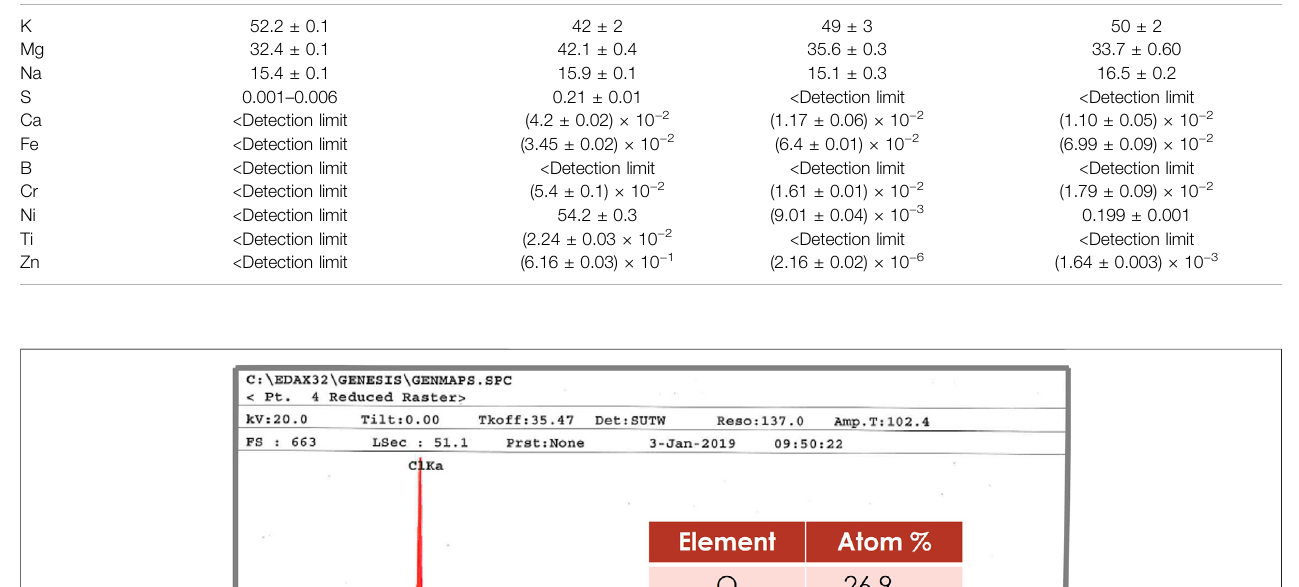
TABLE 3 | Elemental analysis of major and minor components in carnallite salt (wt%-K-Mg-Na). Element Synthetic Carnallite (prior to puri fi cation)